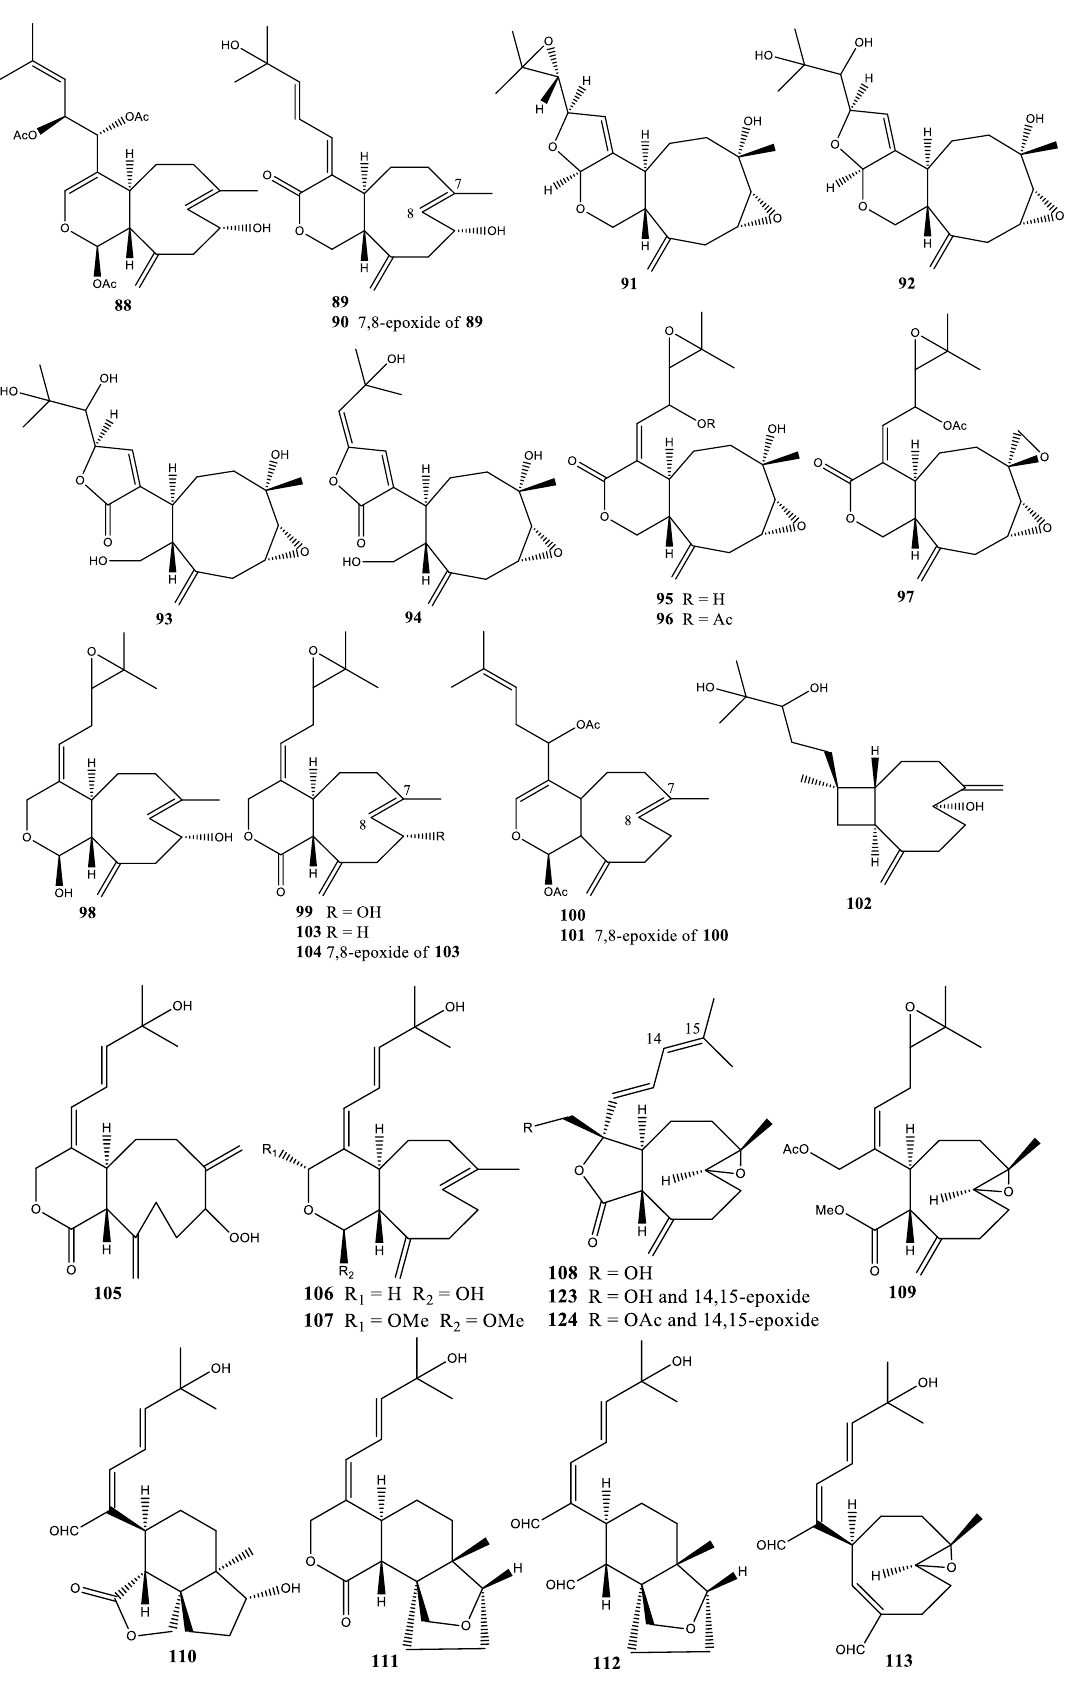
Figure 6. Structures of compounds 88 – 113 and 123 , 124.